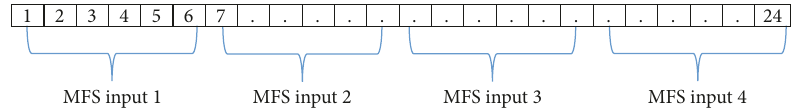
Figure 10: Harmony for the optimization of the MFS.